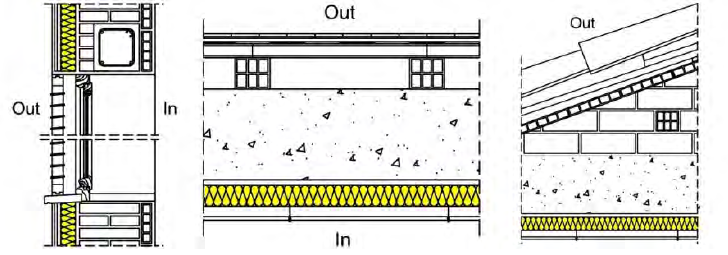
Figure 13. Fac¸ade, sloping roof and flat roof refurbishment solutions